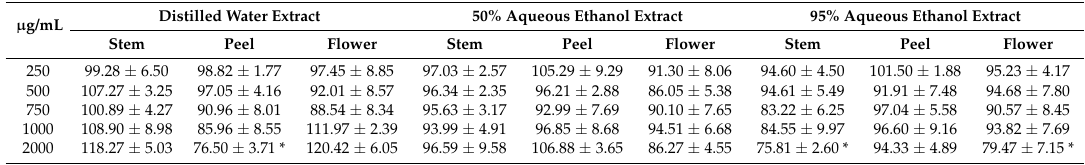
Table 4. The percentage of cell survival for crude extracts from Hylocereus polyrhizus parts as detected using the 3-(4,5-Dimethylthiazol-2-yl)-2,5-diphenyltetrazolium bromide (MTT) cell proliferation assay. µ g/mL Distilled Water Extract 50% Aqueous Ethanol Extract 95% Aqueous Ethanol Extract Stem Peel Flower Stem Peel Flower Stem Peel Flower 250 99.28 ± 6.50 98.82 ± 1.77 97.45 ± 8.85 97.03 ± 2.57 105.29 ± 9.29 91.30 ± 8.06 94.60 ± 4.50 101.50 ± 1.88 95.23 ± 4.17 500 107.27 ± 3.25 97.05 ± 4.16 92.01 ± 8.57 96.34 ± 2.35 96.21 ± 2.88 86.05 ± 5.38 94.61 ± 5.49 108.90 ± 8.98 85.96 ± 8.55 111.97 ± 2.39 93.99 ± 4.91 96.85 ± 8.68 94.51 ± 6.68 84.55 ± 9.97 96.60 ± 9.16 118.27 ± 5.03 76.50 ± 3.71* 120.42 ± 6.05 96.59 ± 9.58 106.88 ± 3.65 86.27 ± 4.55 75.81 ± 2.60* 94.33 ± 4.89 79.47 ±